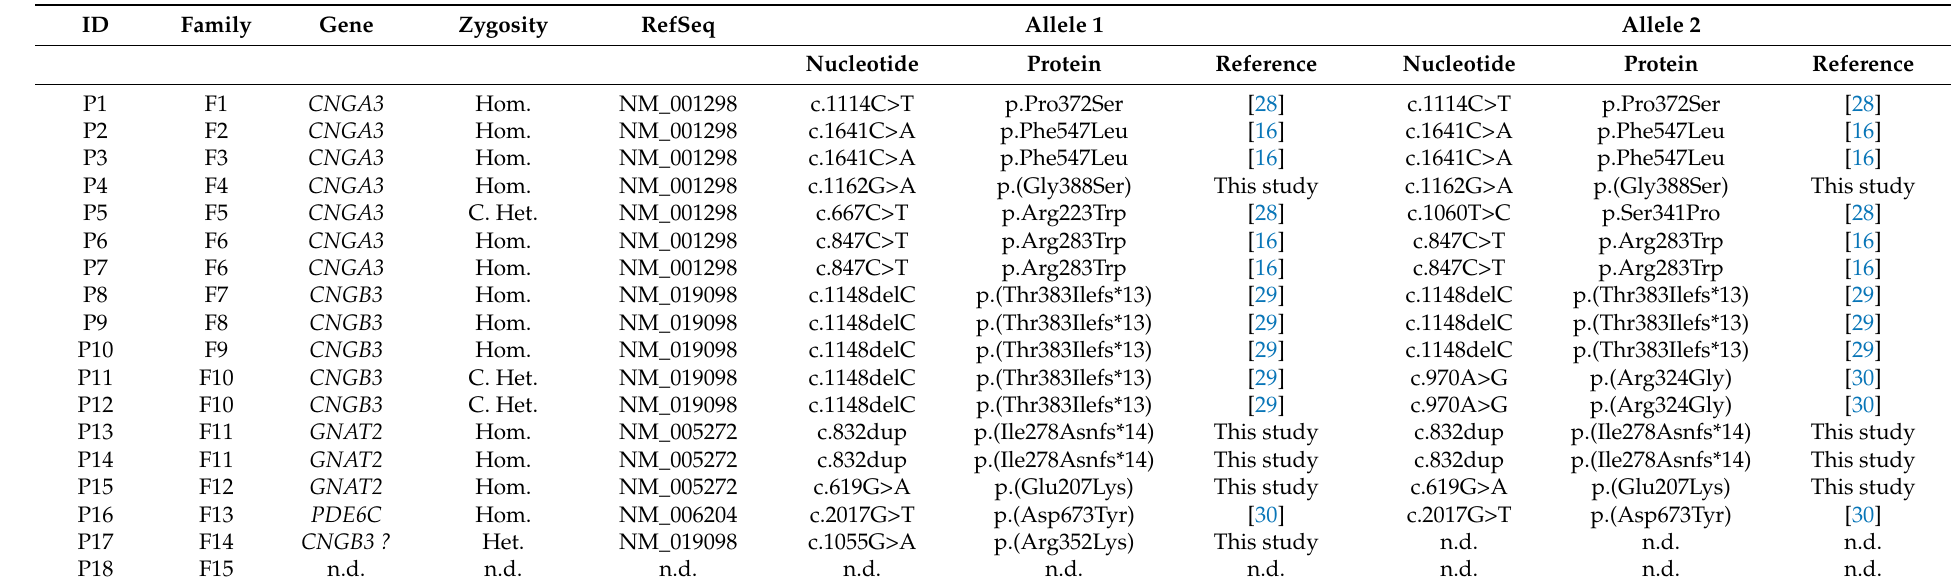
Table 2. Genetic findings in the achromatopsia